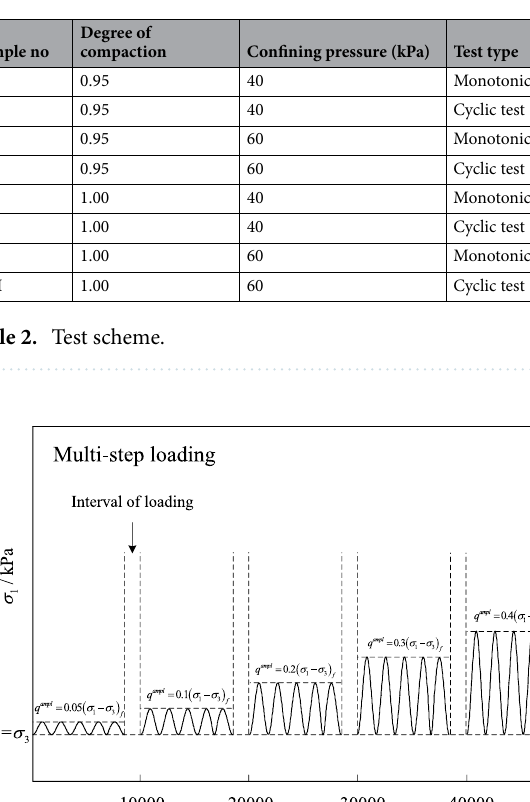
Figure 4. The cyclic loading program.